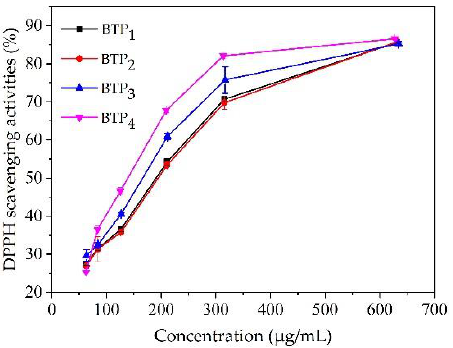
Figure 3. DPPH scavenging activities for BTP S pulverized at different scales.